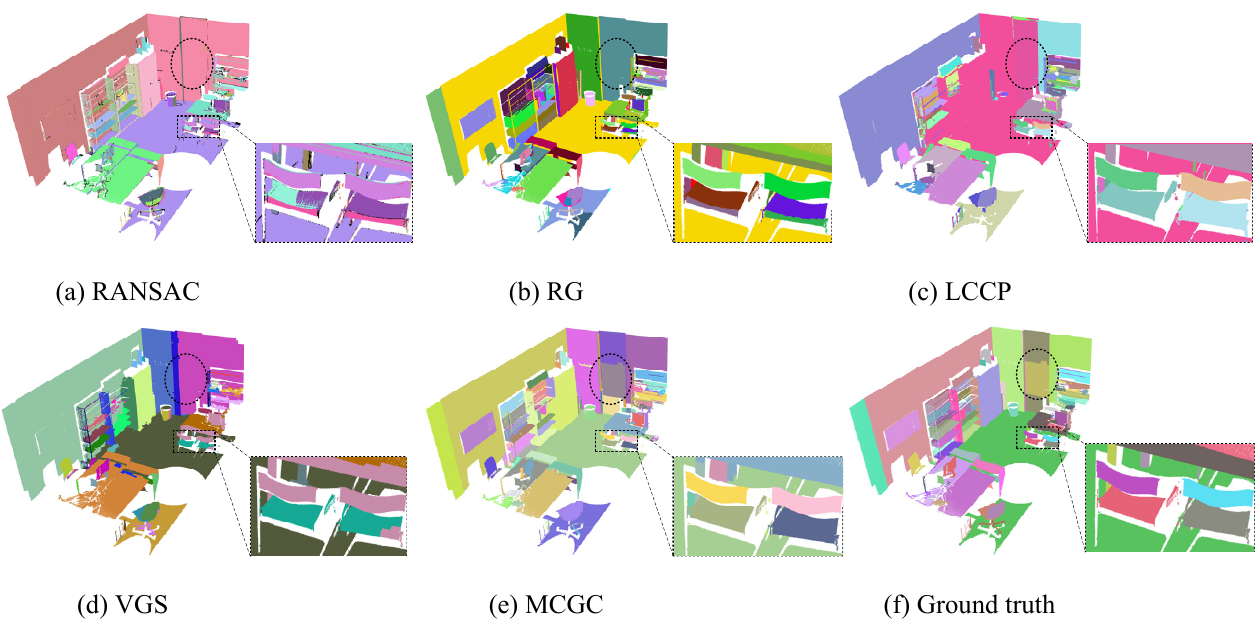
Figure 13. The visual comparison of the Room-L80 by different methods. One local scene slice which is selected to enlarge the segments in the black box. ( a ) The result from RANSAC. ( b ) The result from RG. ( c ) The result from LCCP. ( d ) The result from VGS. ( e ) The result from MCGC. ( f ) The ground truth. Table 6. Performance comparison of indoor segmentation with different methods.